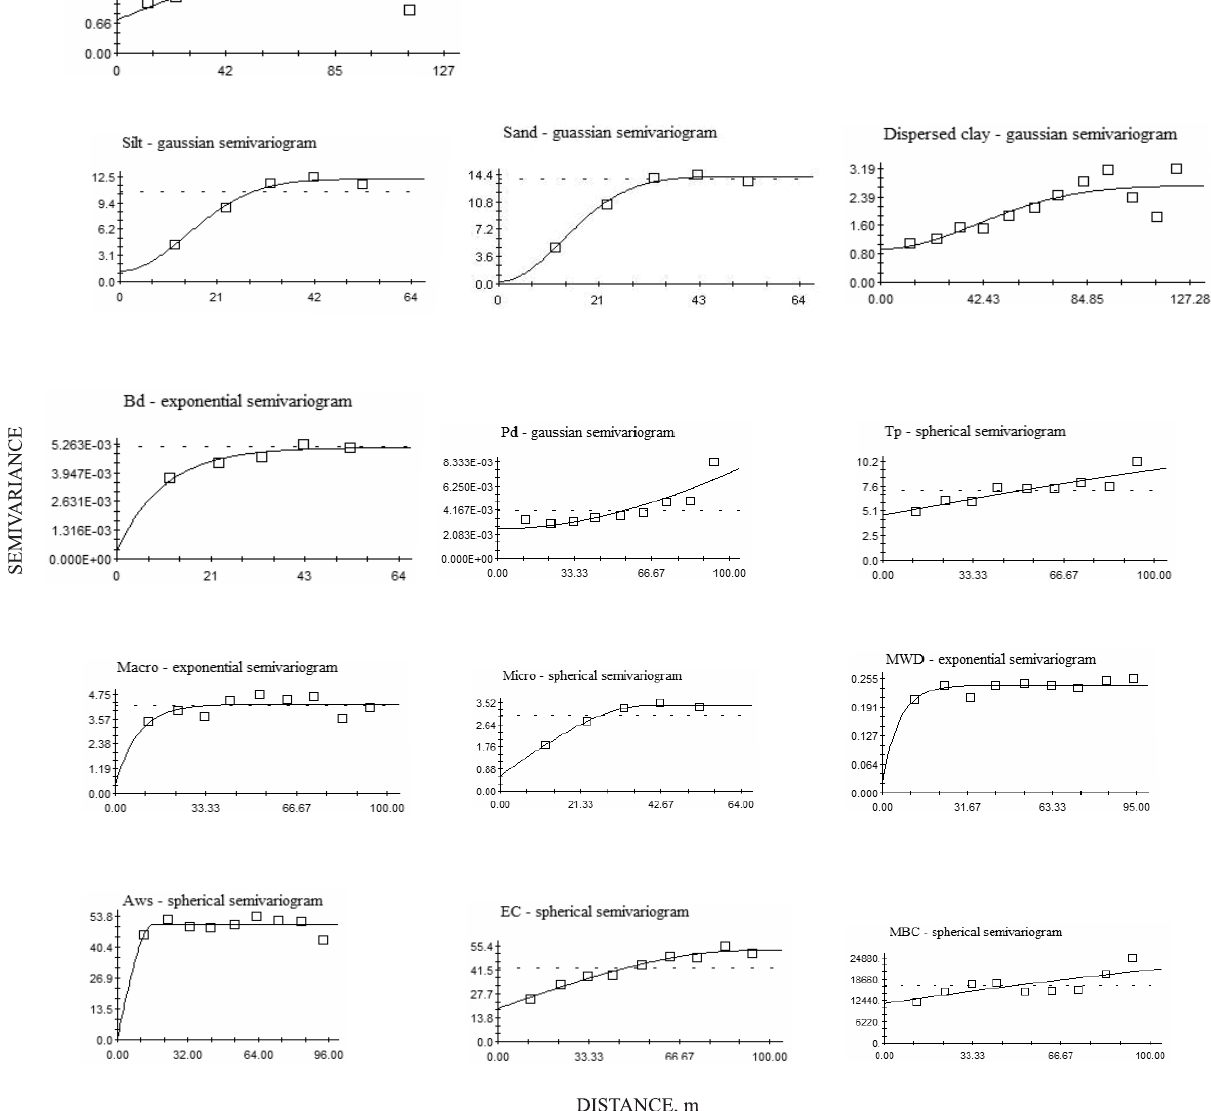
Figure 2. Experimental and theoretical isotropic semivariograms of the physical and biological properties in lowland soil cultivated with irrigated